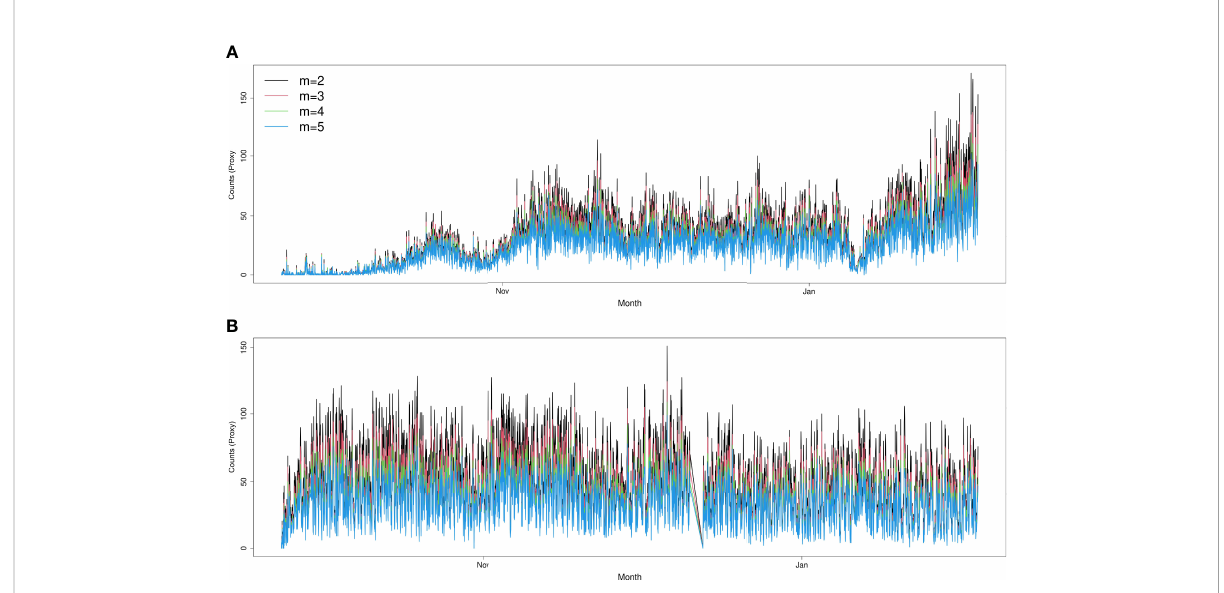
FIGURE 8 Sensitivity analysis of automatic count calculations, by varying the parameter “ m ” (maximum number of consecutive empty frames to declare a track lost) of the tracking algorithm. Increasing the value of “ m ” leads to more conservative results. Sites: Node (A) and Axis (B)